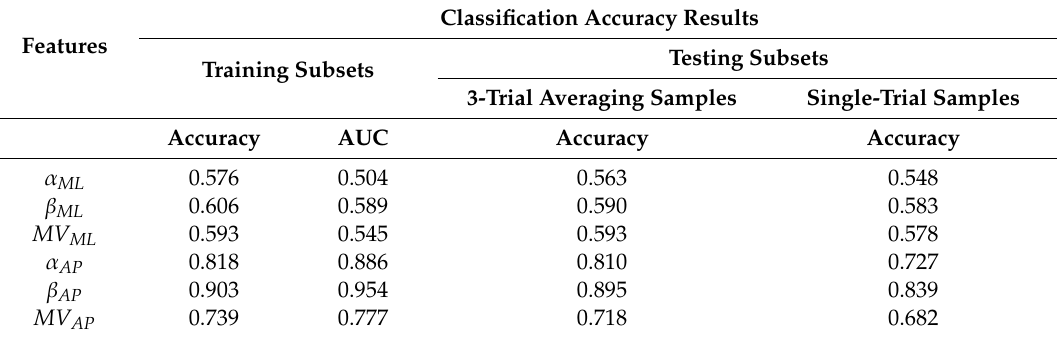
Table 2. Classification results of the tested